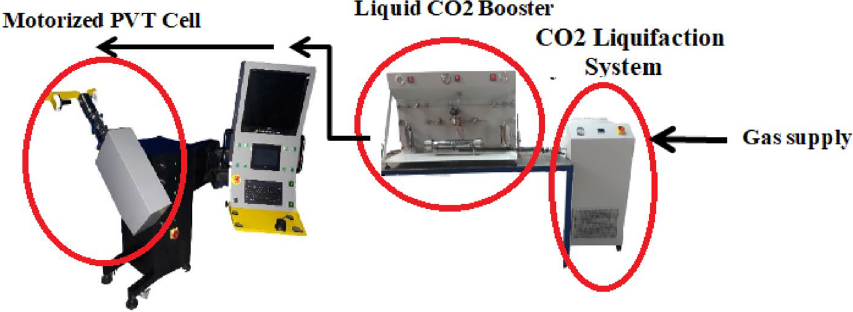
Figure 1. The supercritical based solubility apparatus used in this study. Reprinted with permission from 12